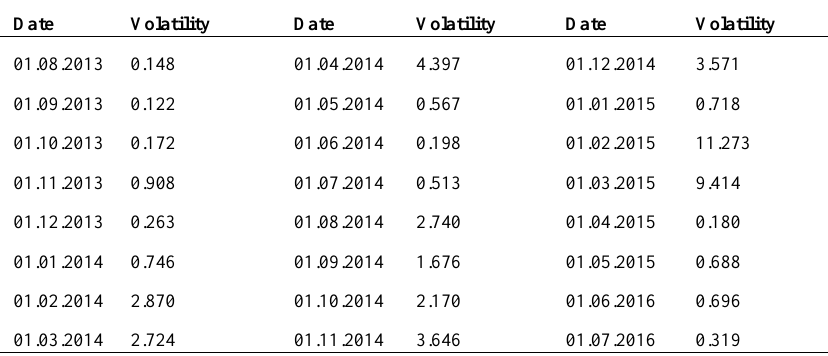
Table 9. Volatility values